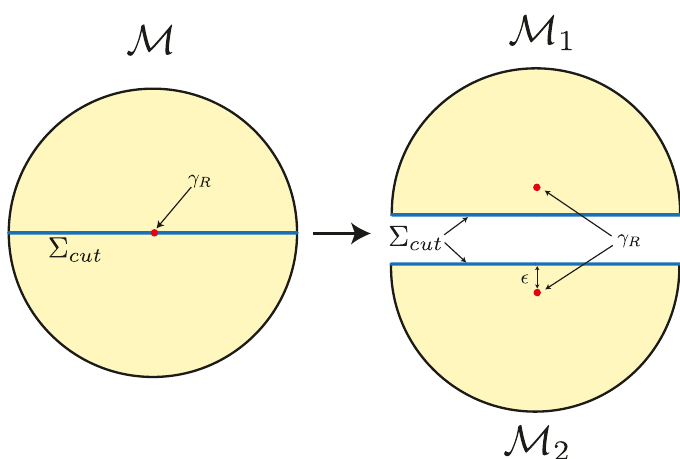
Figure 2 . The saddle point manifold M for h ψ | Π 2 | ψ i can be split into two parts M 1 and M 2 R along a slice Σ cut such that there are two conical defects (red) at γ R , with one on the bra side of the cut and the other on the ket side. On the right, we have added a regulator (cid:15) that moves each of the resulting singularities away from the cut. The original M should be understood as the limit (cid:15) → 0 where the two γ R surfaces